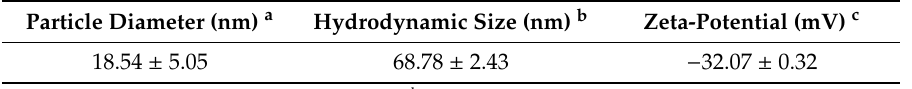
Figure 2. Characterization of amorphous silica nanoparticles (SiO 2 NPs). ( A ) Representative TEM image and size distribution histogram of SiO 2 NPs. ( B ) Representative SEM image of the SiO 2 NPs. ( C ) energy dispersive X-ray detection (EDX) analysis of SiO 2 NPs. ( D , E ) Representative dynamic light scattering (DLS) measurement of SiO 2 NPs for ( D ) hydrodynamic size and ( E ) zeta potential. Table 1. Physico-chemical characterization of SiO 2 NPs.